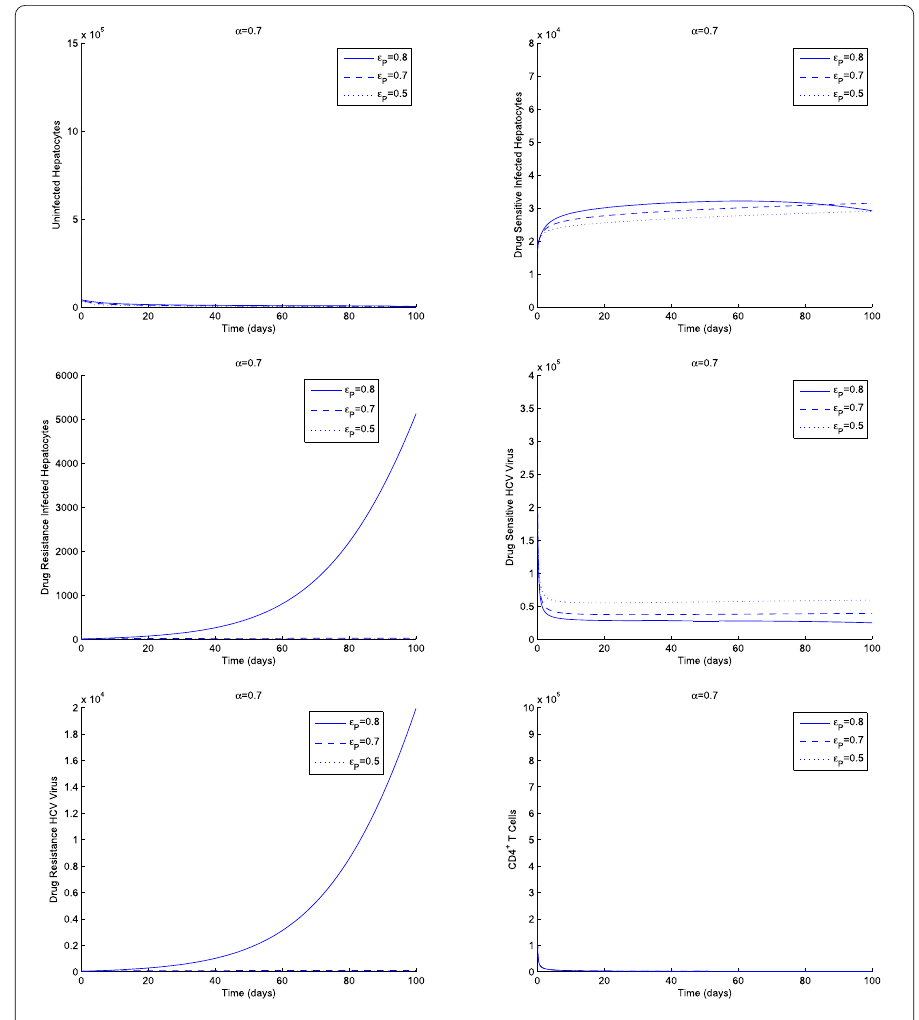
Figure 8 Dynamics of the variables of system (1) for different values of (cid:3) P , the protease inhibitor drug efficacy, and α = 0.7. Parameter values are in Table 1 and initial conditions are given in the text.